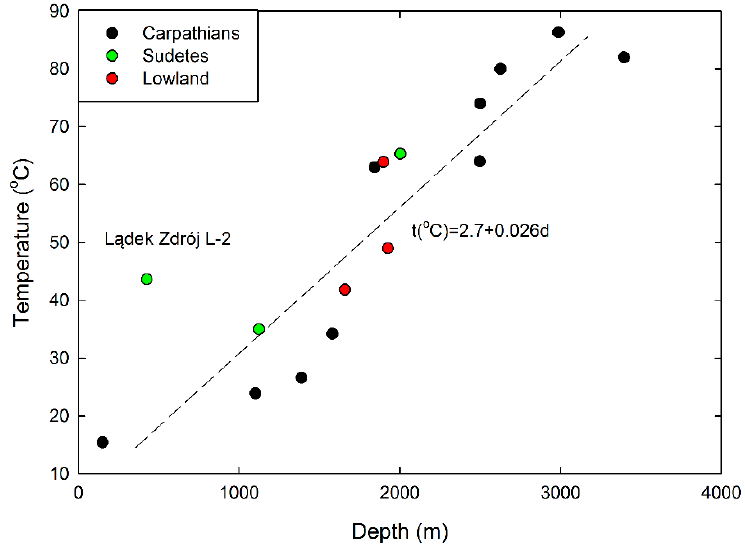
Figure 3. Relationship between water temperature and aquifer depth.